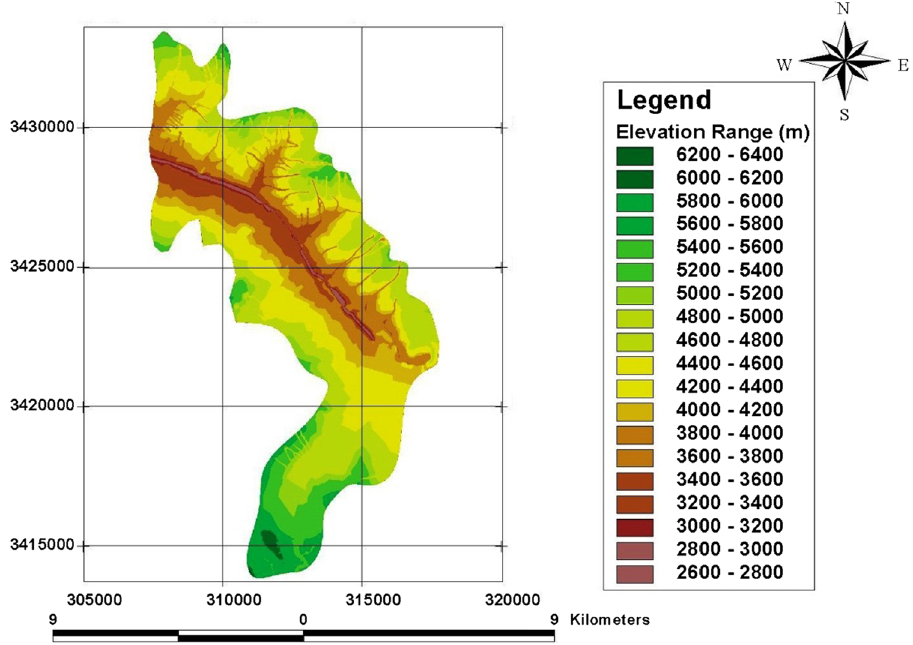
Fig. 3 Digital elevation model of the Gangotri glacier